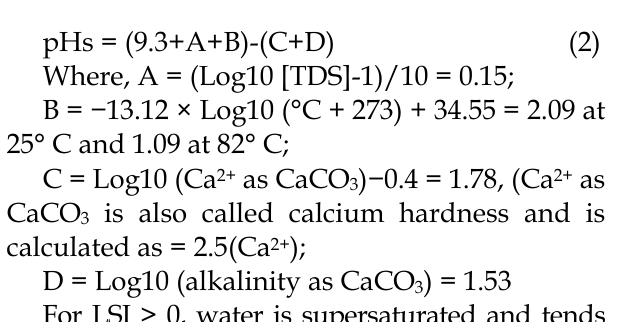
Figure 1. Location and sampling points of study